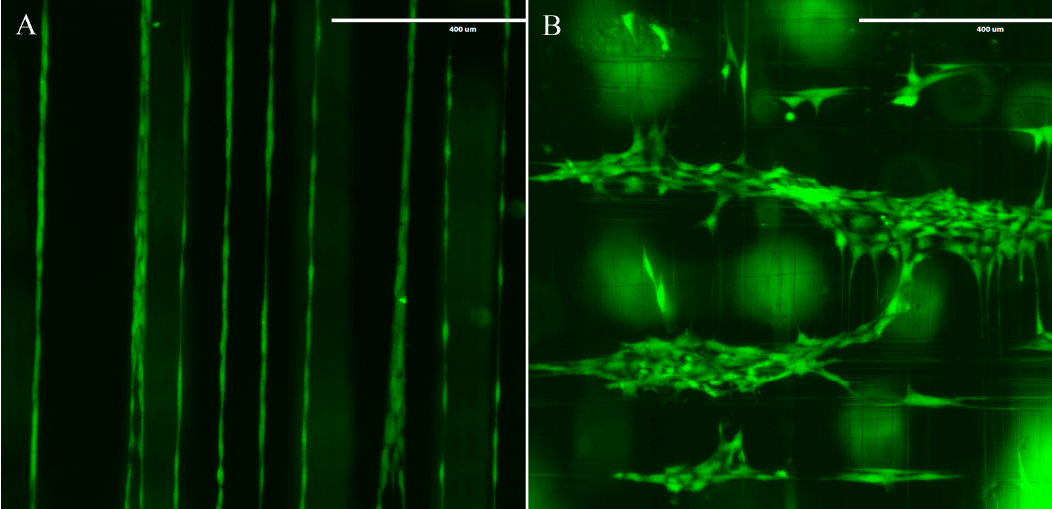
Figure 4. Viability of MSCs on aligned scaffolds. MSCs stained with calcein AM on parallel scaffolds ( A ) and perpendicular scaffolds ( B ) after 14 days of culture. Scale bar 400 μ m. MSCs cultured for 12 days on fibrous scaffolds elongated along aligned parallel fibers in both 5). Intracellular F-actin stained with rhodamine phalloidin and nuclei stained with DAPI were